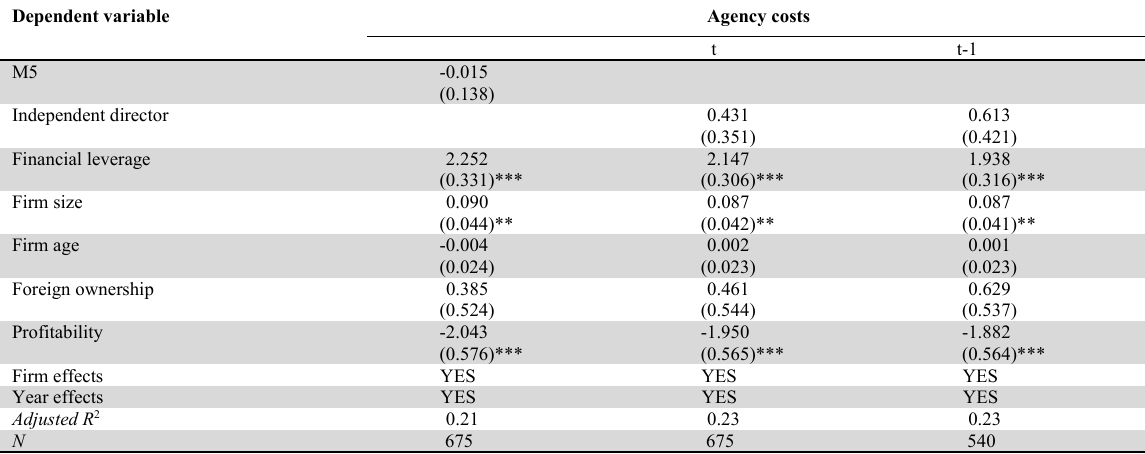
Robustness test using an alternative proxy for board independence Dependent